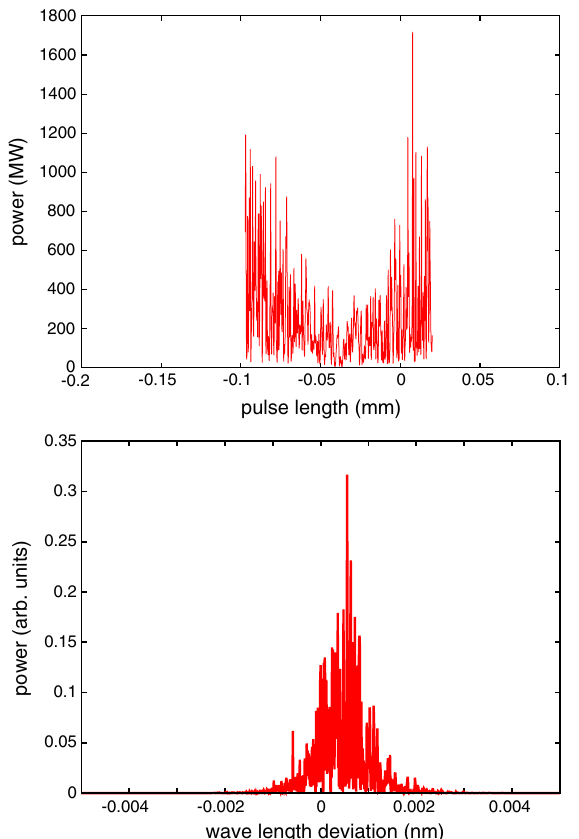
FIG. 14. Temporal (top) and spectral (bottom) profiles of the 1 nm x-ray radiation at the end of the first undulator section in the SASE FEL scheme.